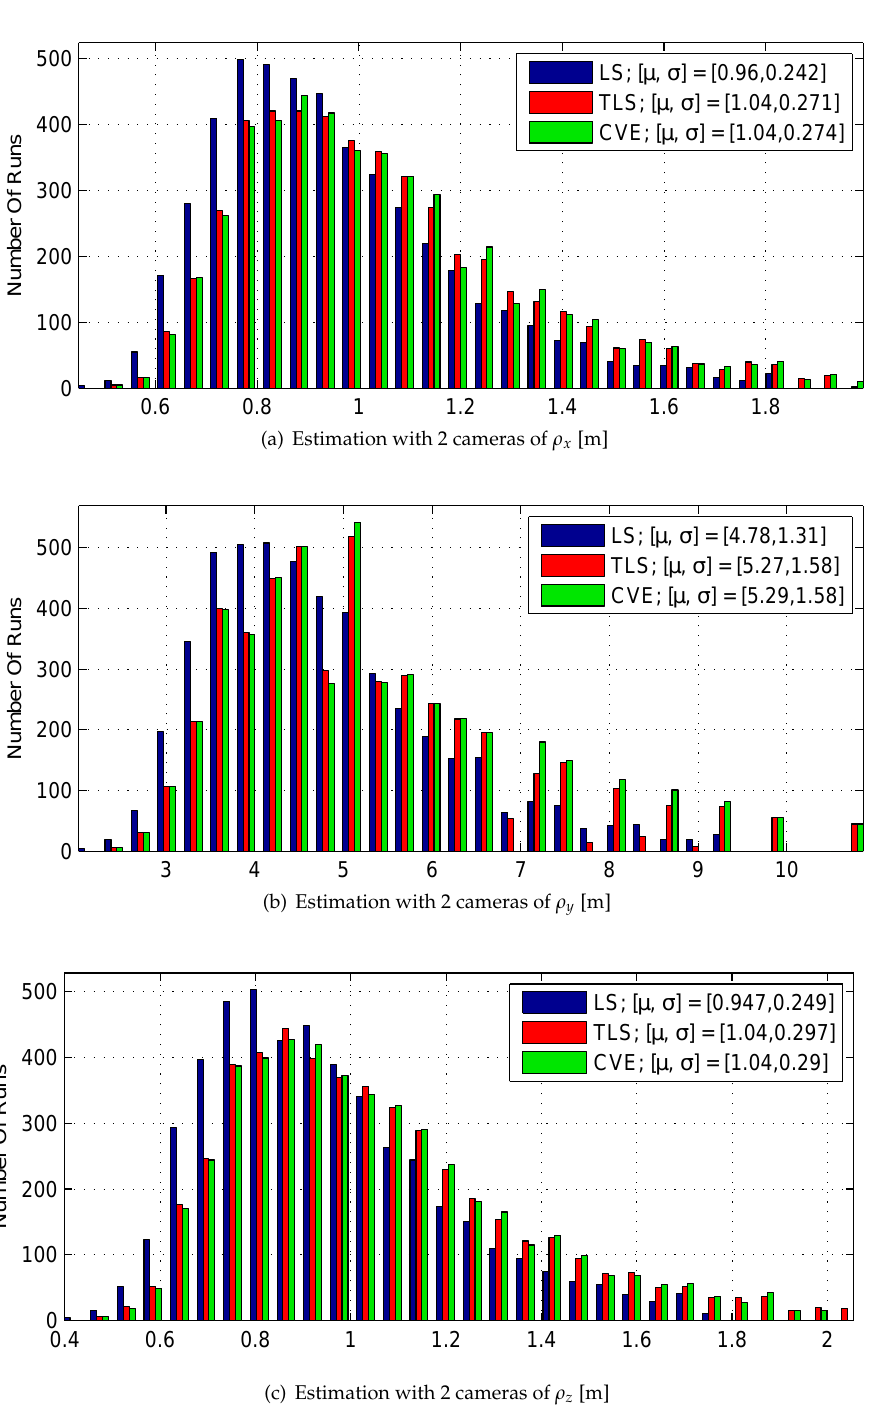
Figure 8. Monte carlo results of a static LOS estimation using stereovision measurements with 2